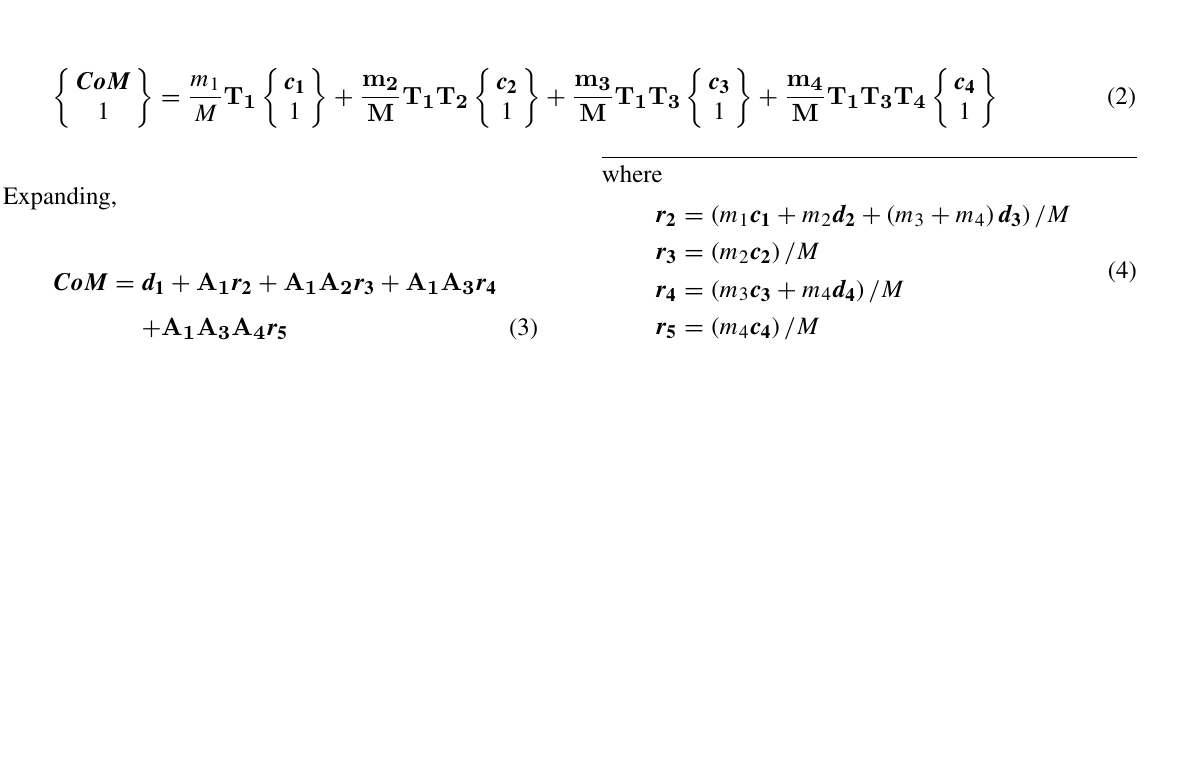
Fig. 2. (a) represents a four degree of freedom tree chain and (b) represents the statically equivalent serial chain locating the CoM of the original chain